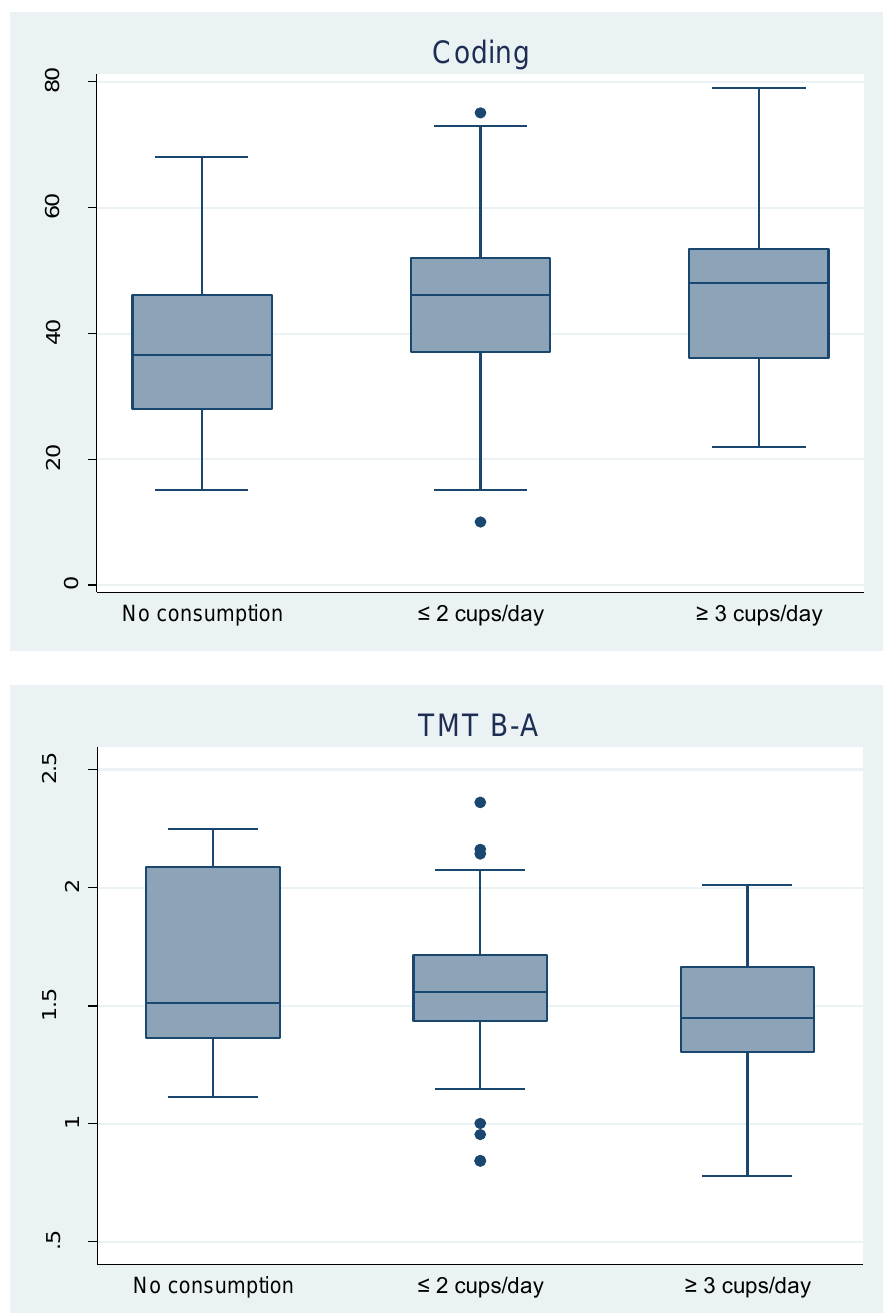
Figure 1. Distribution of raw test scores of HIV-HCV coinfected patients in the study population, the ANRS CO13 HEPAVIH cohort and the HEPAVIH-Psy cross-sectional survey (N = 139). Abbreviations: ROCF: Rey-Osterrieth complex figure; TMT B-A: Trail Making Test part B minus A. 3.3. Co ff ee Consumption Associated with Neurocognitive Performance in HIV-HCV Coinfected